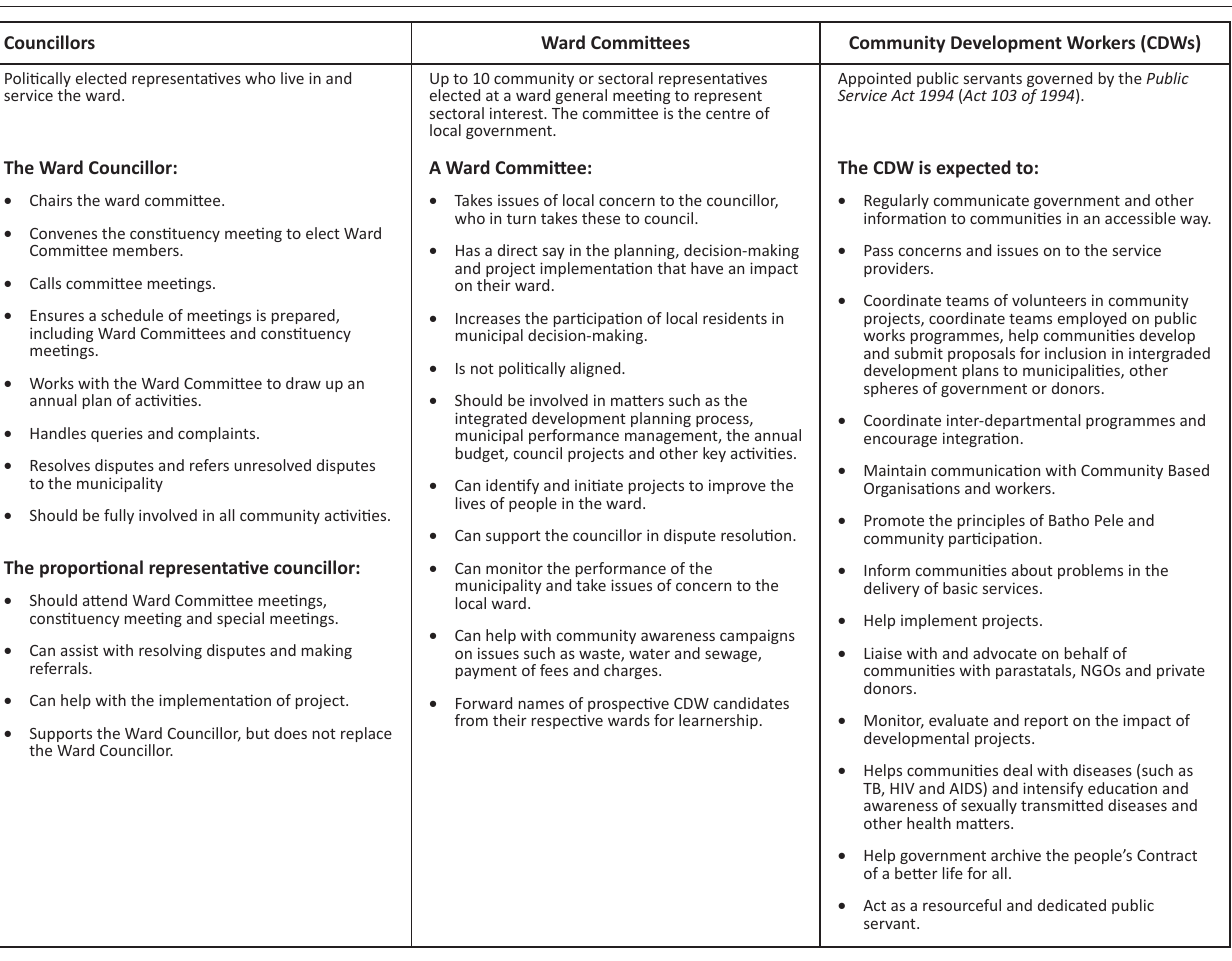
FIGURE 1: Roles and responsibilities of Ward Councillors, Ward Committees and community development workers.